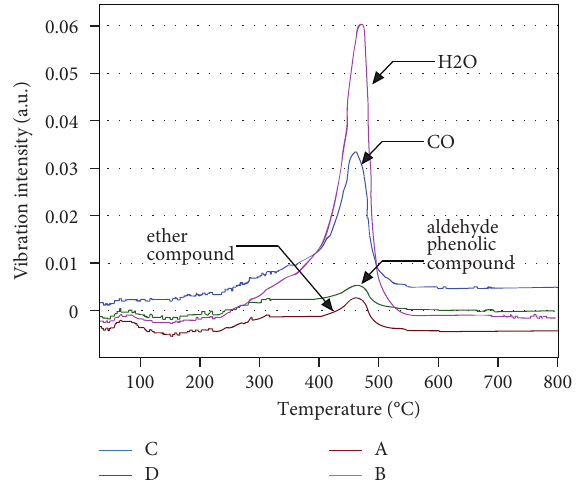
Figure 12: Vibrationintensity versustemperature for gaseousproducts during the combustion of the Bulianta 12# raw coal